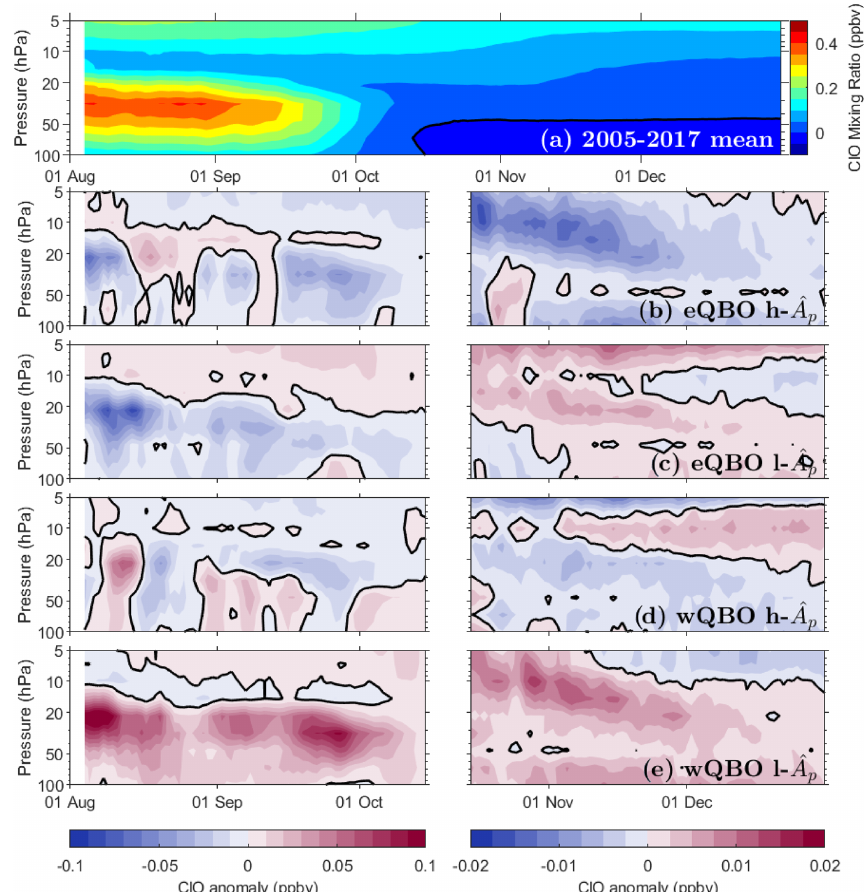
Figure 6. (a) Polar (60–82 ◦ S, area-weighted) daytime MLS ClO composite mean over the 2005–2017 period. The contour interval is 0.05ppbv. The y axis is the pressure from 100 to 5hPa, and the x axis is the time from 1 August to the end of December. (b–e) The anomaly from the mean for (b) eQBO years and high (cid:99) Ap, (c) eQBO years and low (cid:99) Ap, (d) wQBO years and high (cid:99) Ap, and (e) wQBO years and low (cid:99) Ap. Due to the large change in ClO levels taking place in October, the left column presents the anomaly from 1 August to 15 October (contour interval of 0.01ppbv), and the right column continues from 15 October to the end of December (contour interval of 0.0025ppbv). The black line indicates the zero